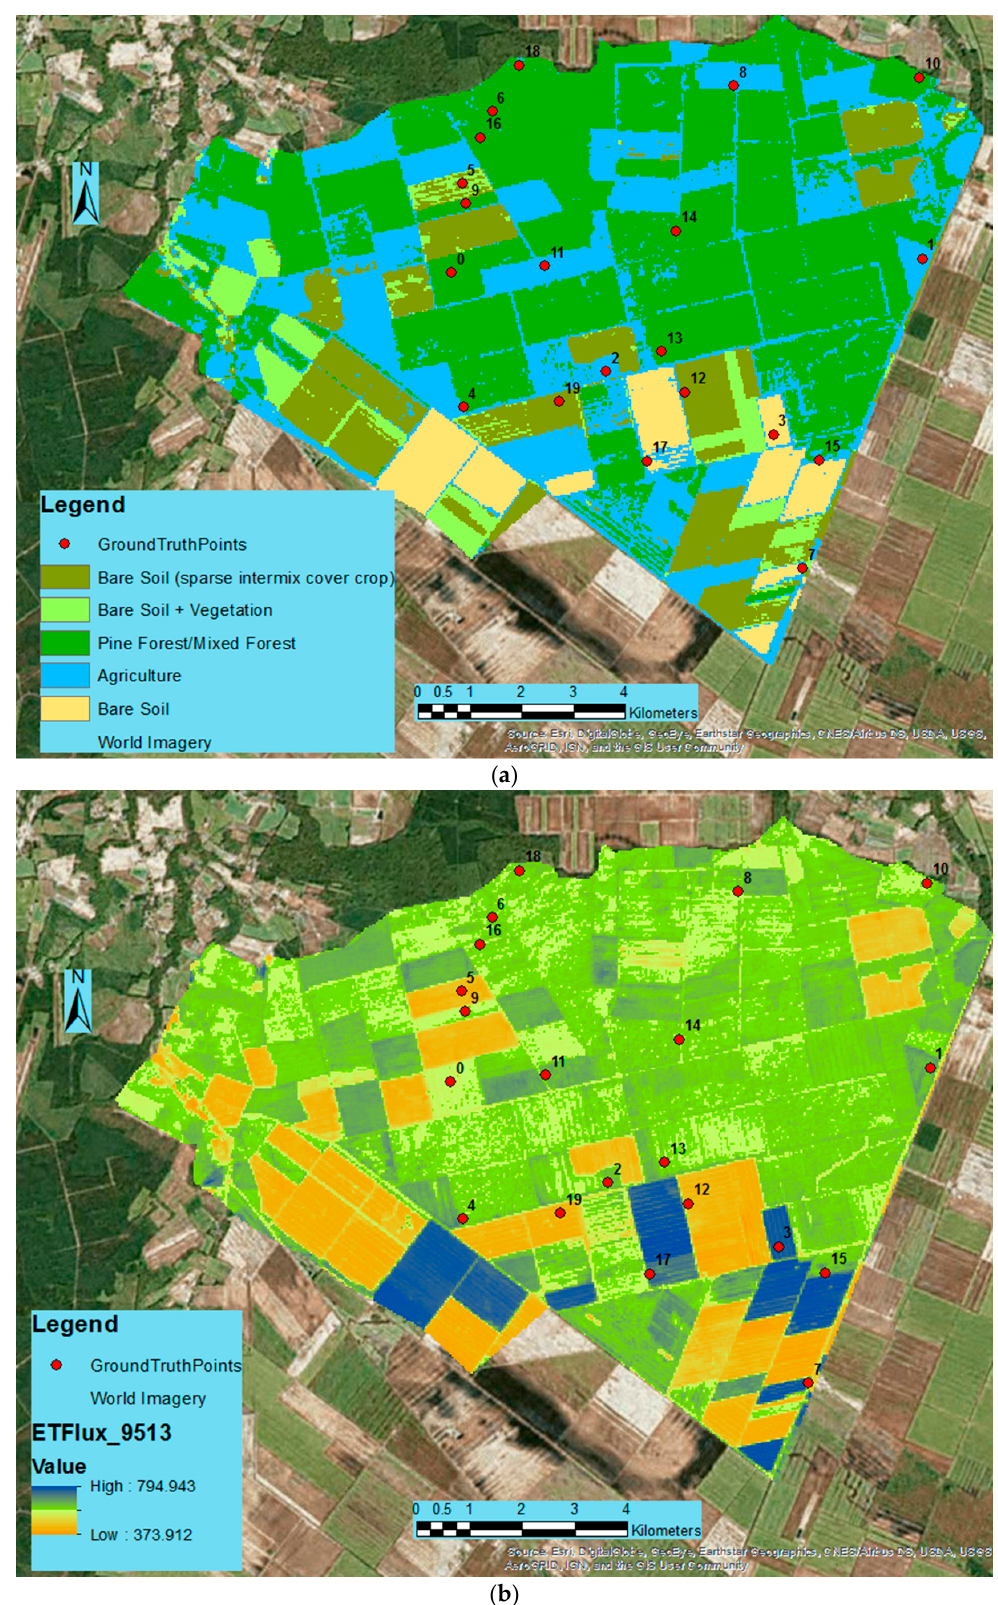
Figure 8. ( a ) Landuse versus ( b ) ET flux analysis with stratified random ground-truth points of 5 September 2013 in the study area.